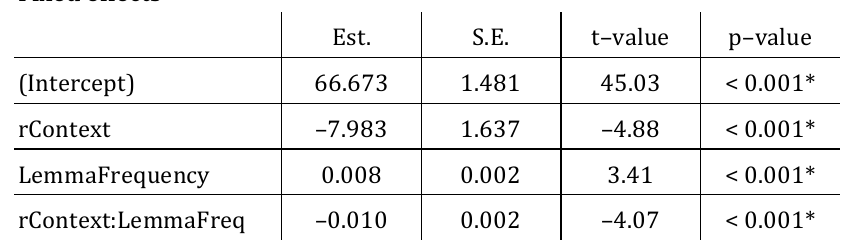
Table 2: Mixed-effects model for West Middle German